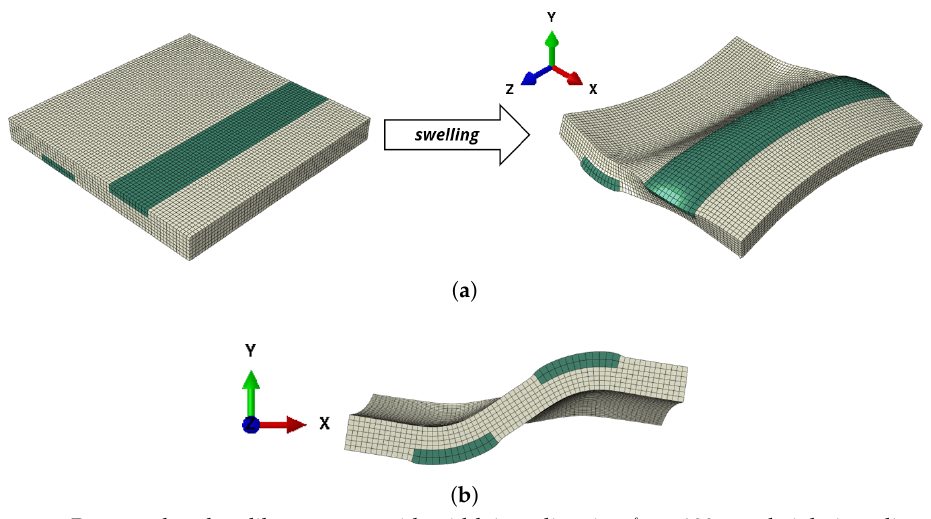
Figure 10. Rectangular plate-like structure with width in x -direction (cid:96) x = 100mm, height in y -direction (cid:96) y = 10mm and length in z -direction (cid:96) z = 100mm. Due to the included hydrogel patches, an S-form according to Figure 9 evolves under swelling. ( a ) Structure that forms a corrugated shell. The deformed state is at ϑ = 34 ◦ C. The dimensions of the hydrogel patches are equal to the ones in Figure 9. The results were obtained with Abaqus according to Section 2 with 30485 quadratic hexahedral elements of type C3D20R. ( b ) Cut through the deformed state at the middle z cut =